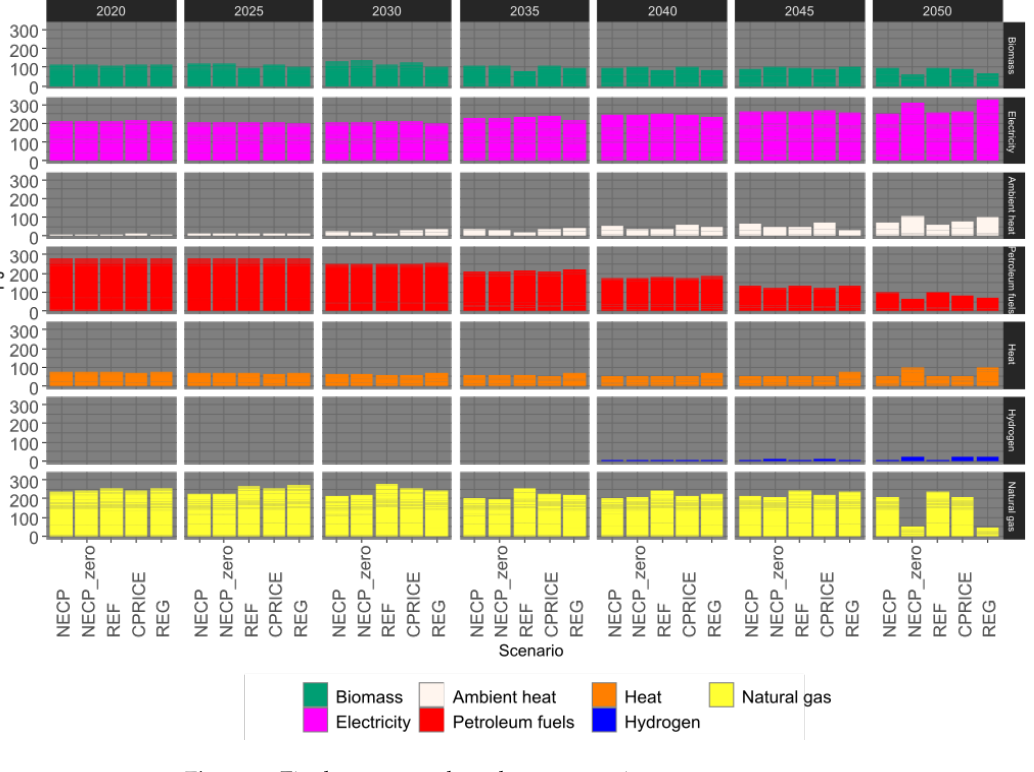
Figure 5. Final energy — selected energy carriers.